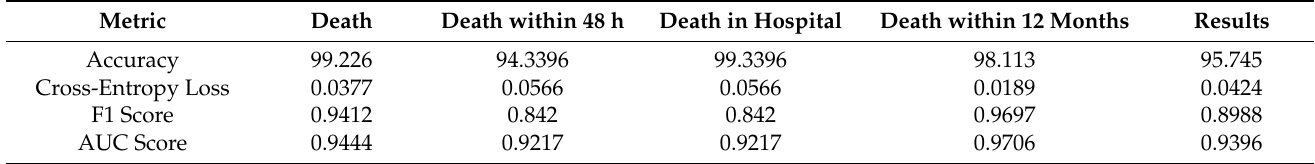
Table 4. Results from evaluation